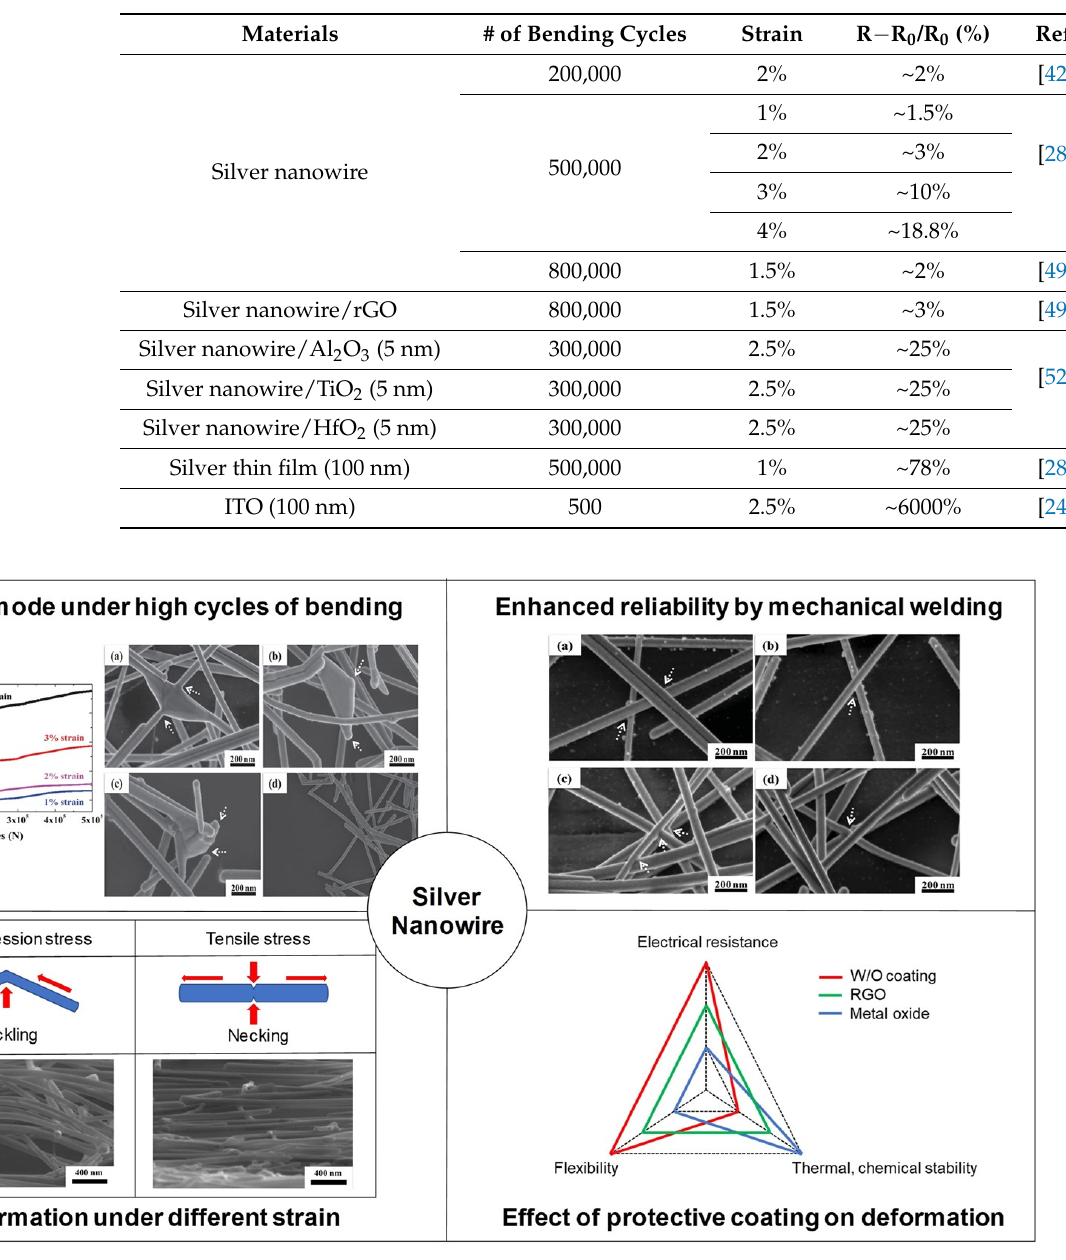
Figure 20. Graphical summary of the review paper. Some of the graphs are reproduced with permission from ref. [28].